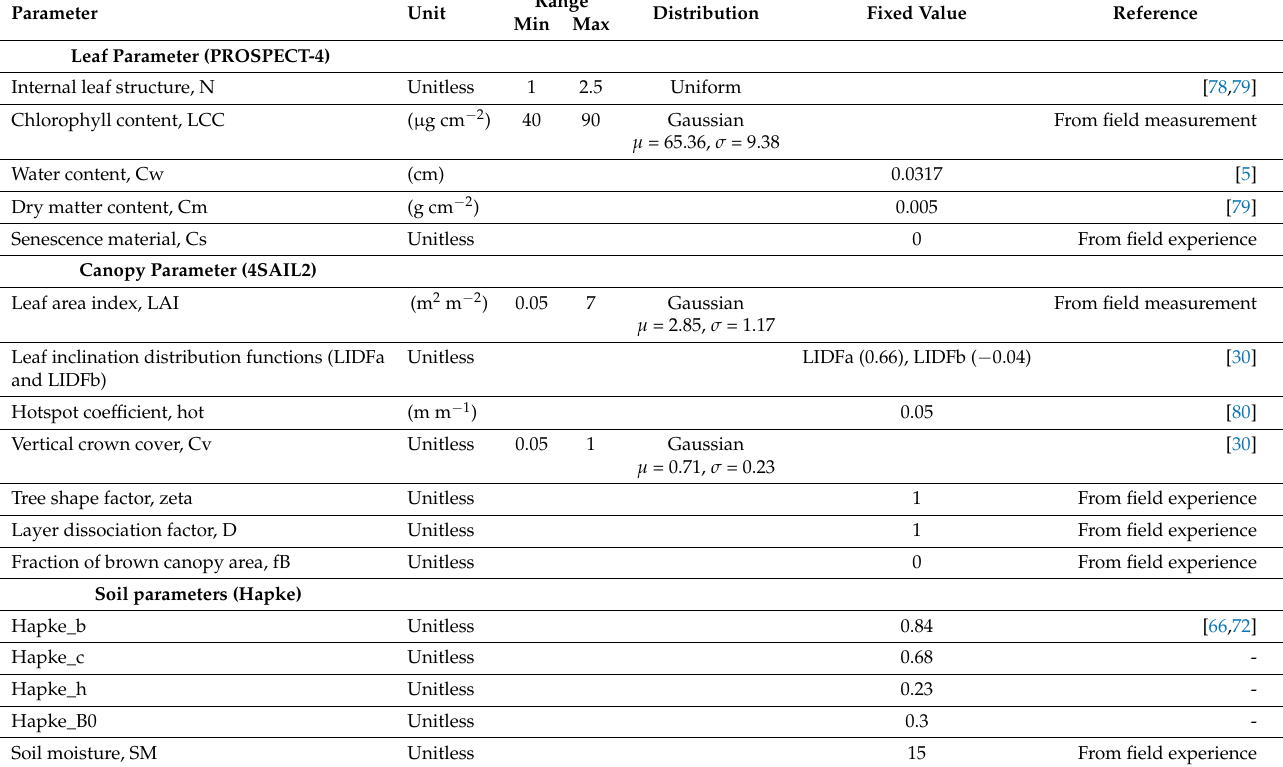
Table 2. Input parameters of the Soil–Leaf–Canopy (SLC) model used for generating a look-up table